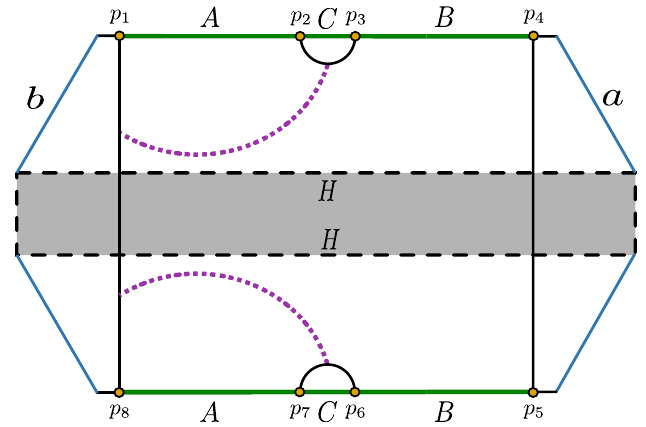
Figure 30 . The endpoints of the intervals A and B in the two BCFT 2 copies are identified similarly as in figure